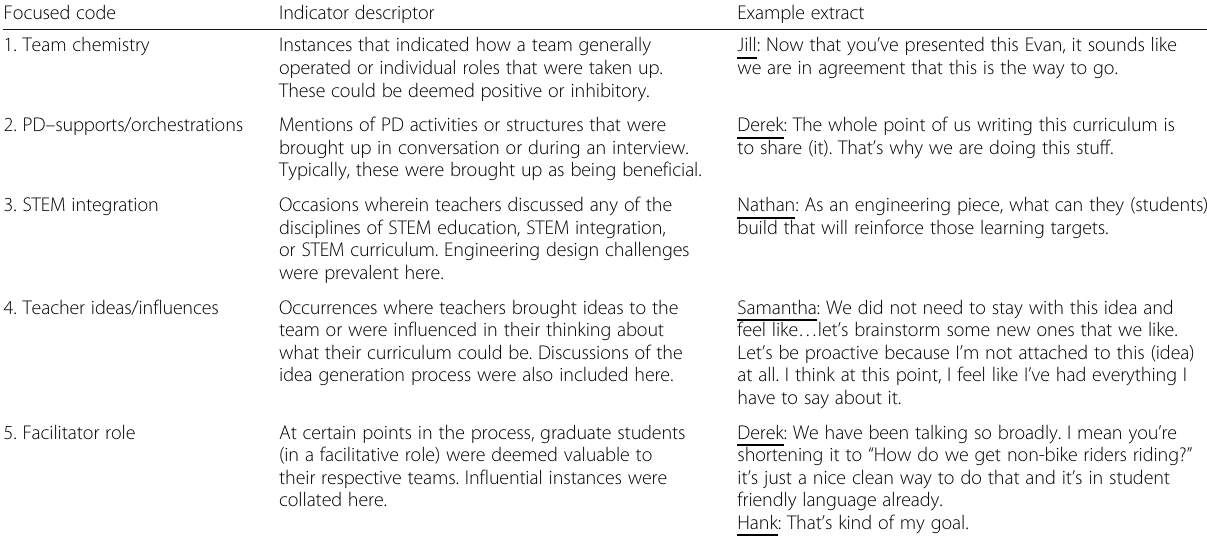
Table 3 Cross-team focused codes, descriptor, and example extracts Focused